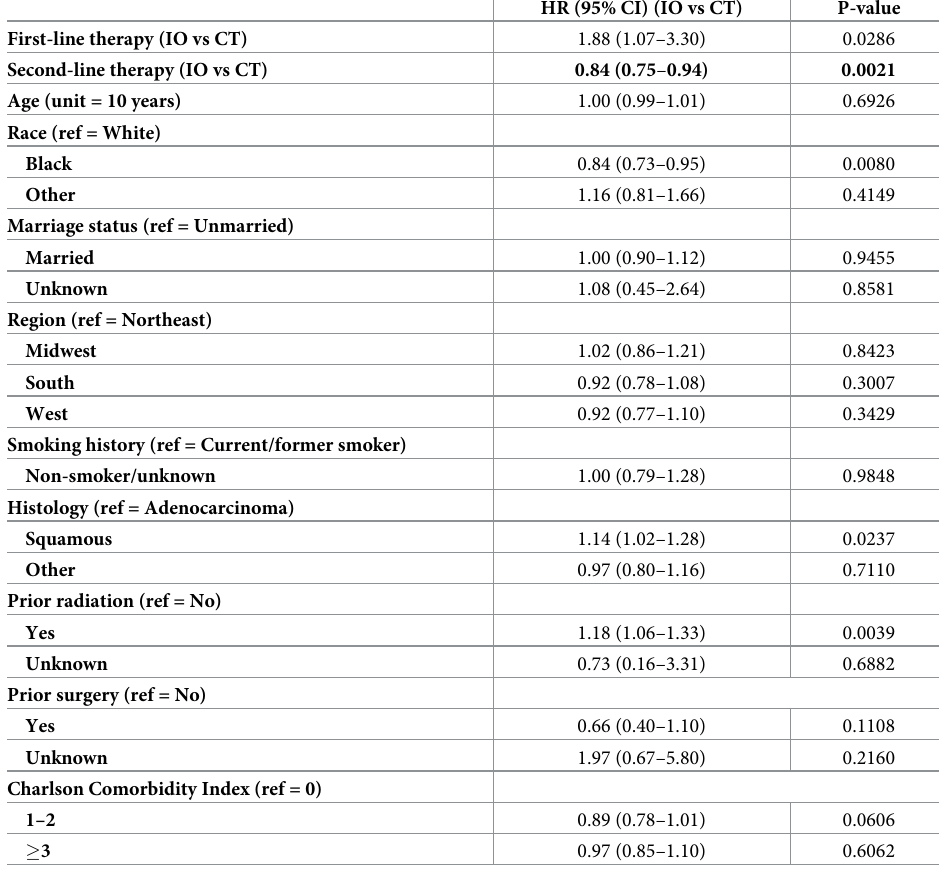
Table 3. Inverse probability weighting Cox proportional hazard regression to evaluate the effect of treatment on